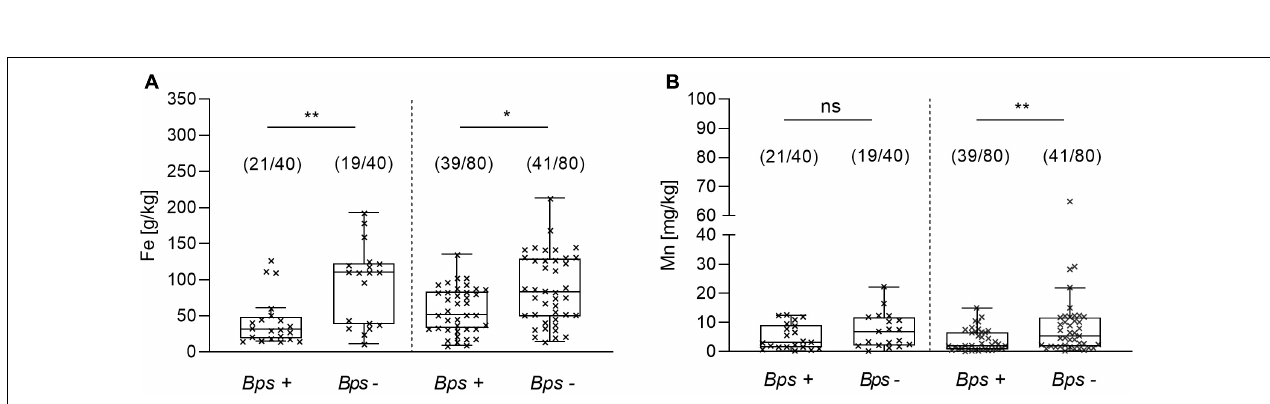
FIGURE 8 | Difference in the iron and manganese concentration between B. pseudomallei positive (Bps+) and negative (Bps–) soil samples. Concentration of (A) iron in the monsoon (left side) and dry season (right site) and of (B) manganese. The term ‘dry season’ refers to the post-monsoon and summer season (Kruskal–Wallis, Dunn’s test; ns, not significant; * p < 0.05, ** p < 0.01). Boxes line values from the 25th to 75th percentiles of a data set; the vertical line in a box plot marks the median value. The whiskers from the lower and upper quartile represent 1.5 times the interquartile